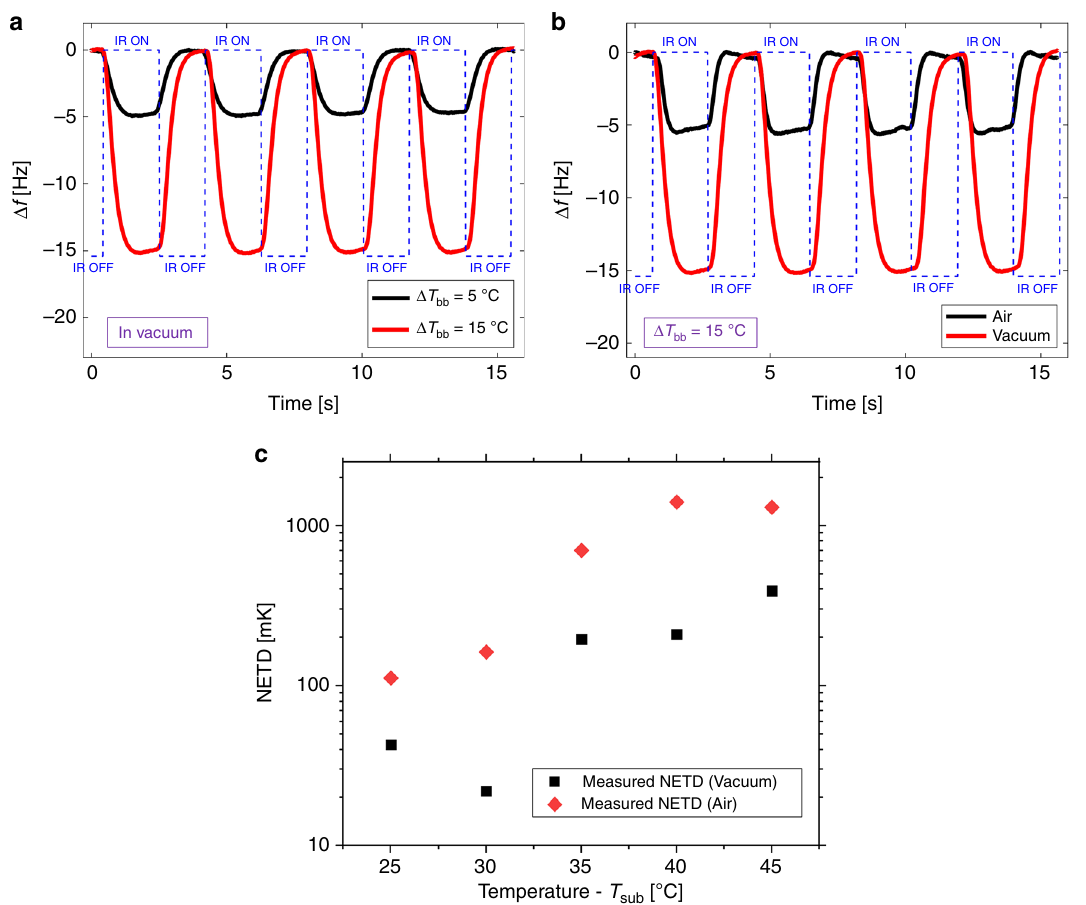
Fig. 4 NETD measurements of the IR SMP sensor. a The frequency response of the SMP IR sensor in vacuum at T sub = 30 °C operation temperature when the target temperature is periodically changed by Δ T bb = 5° and by Δ T bb = 15°. b The frequency response of the IR resonator at T sub = 30 °C operation temperature in vacuum and at 1 atmosphere. c Measured NETD vs. operation temperature in vacuum and in air